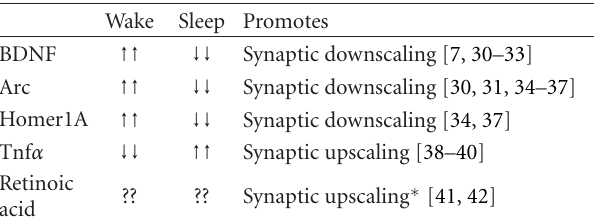
Table 1: Scaling factors and the sleep-wake